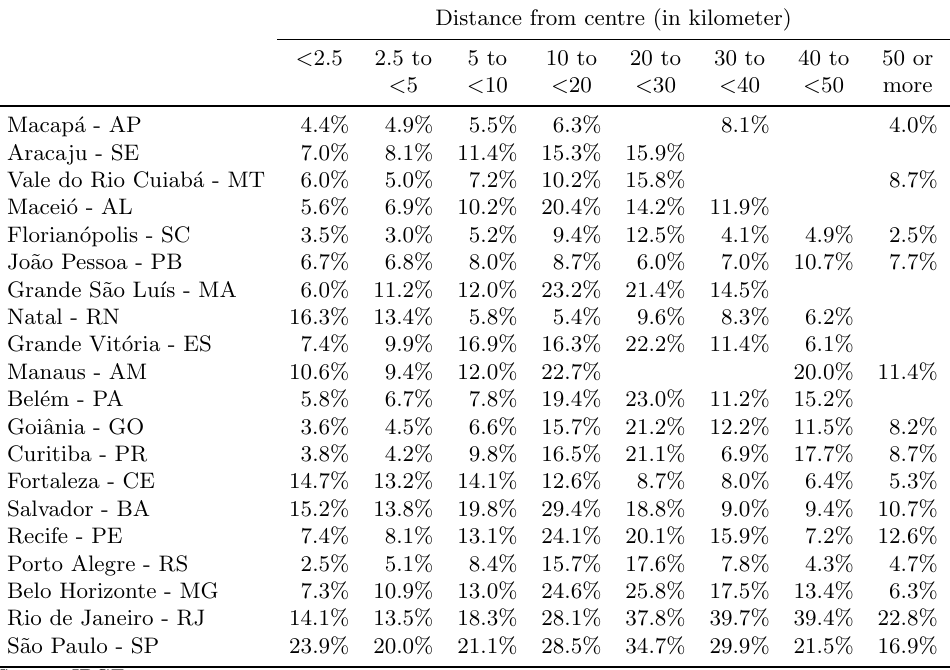
Table 2: Percentage of workers who spend more than one hour commuting from home to work, according to the distance the worker lives from the centre, (ordered by the size of working population), 2010